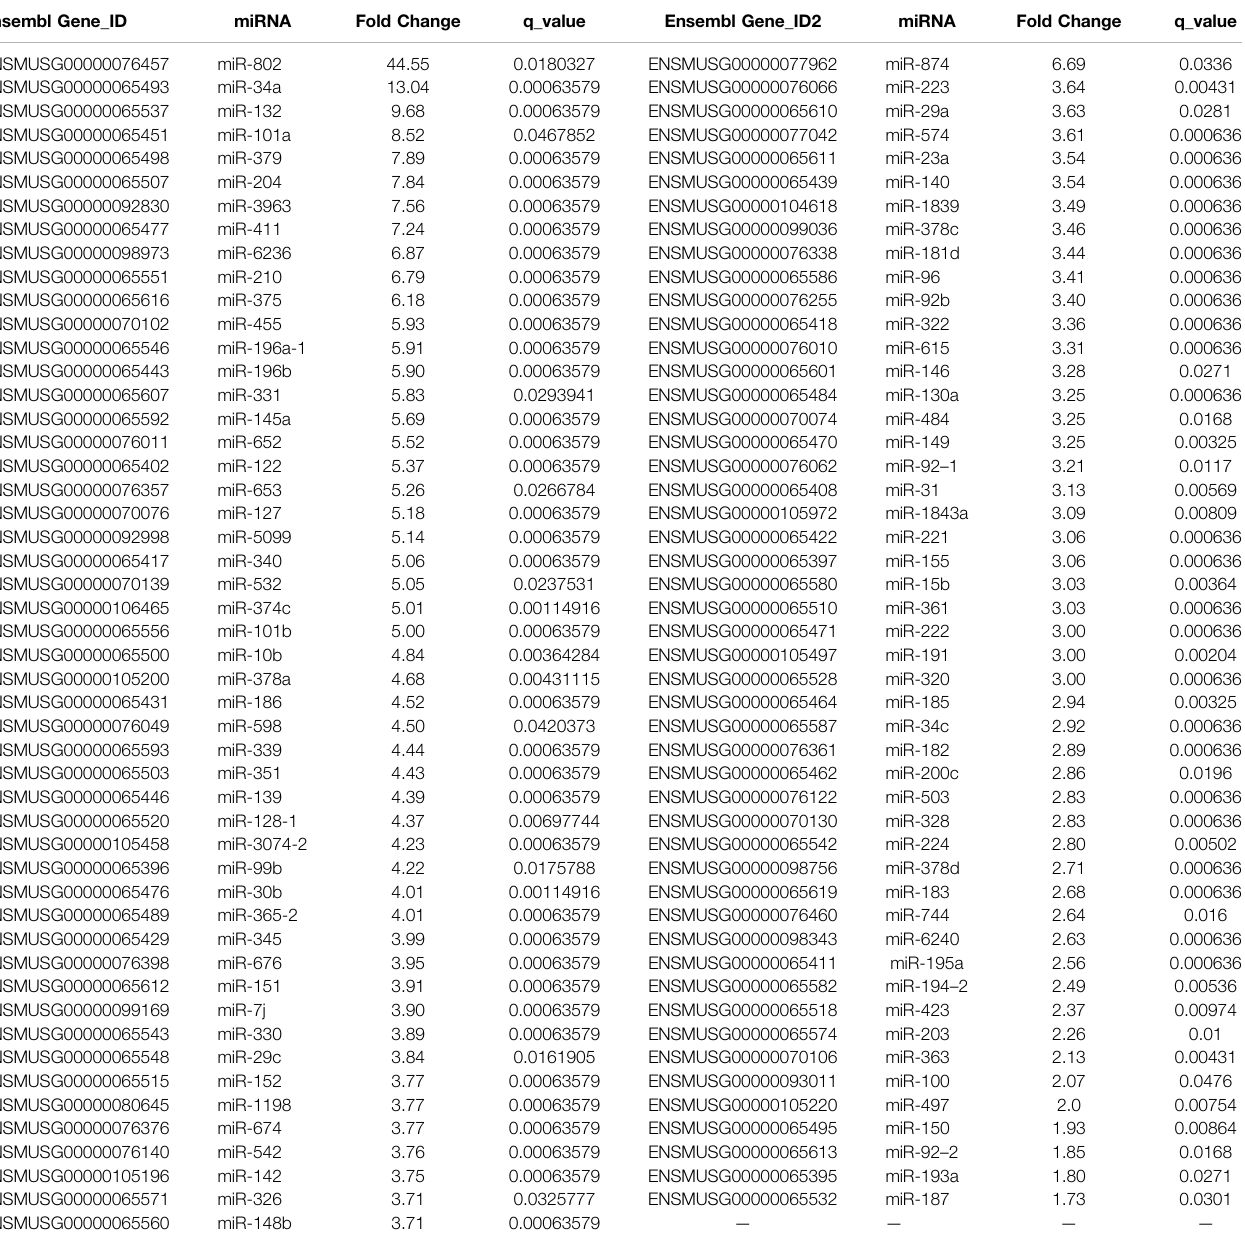
TABLE 2 | List of the 99 miRNAs presenting q-values < 0.05 in the comparative analysis of BTBR ob/ob vs. BTBR WT group. Ensembl